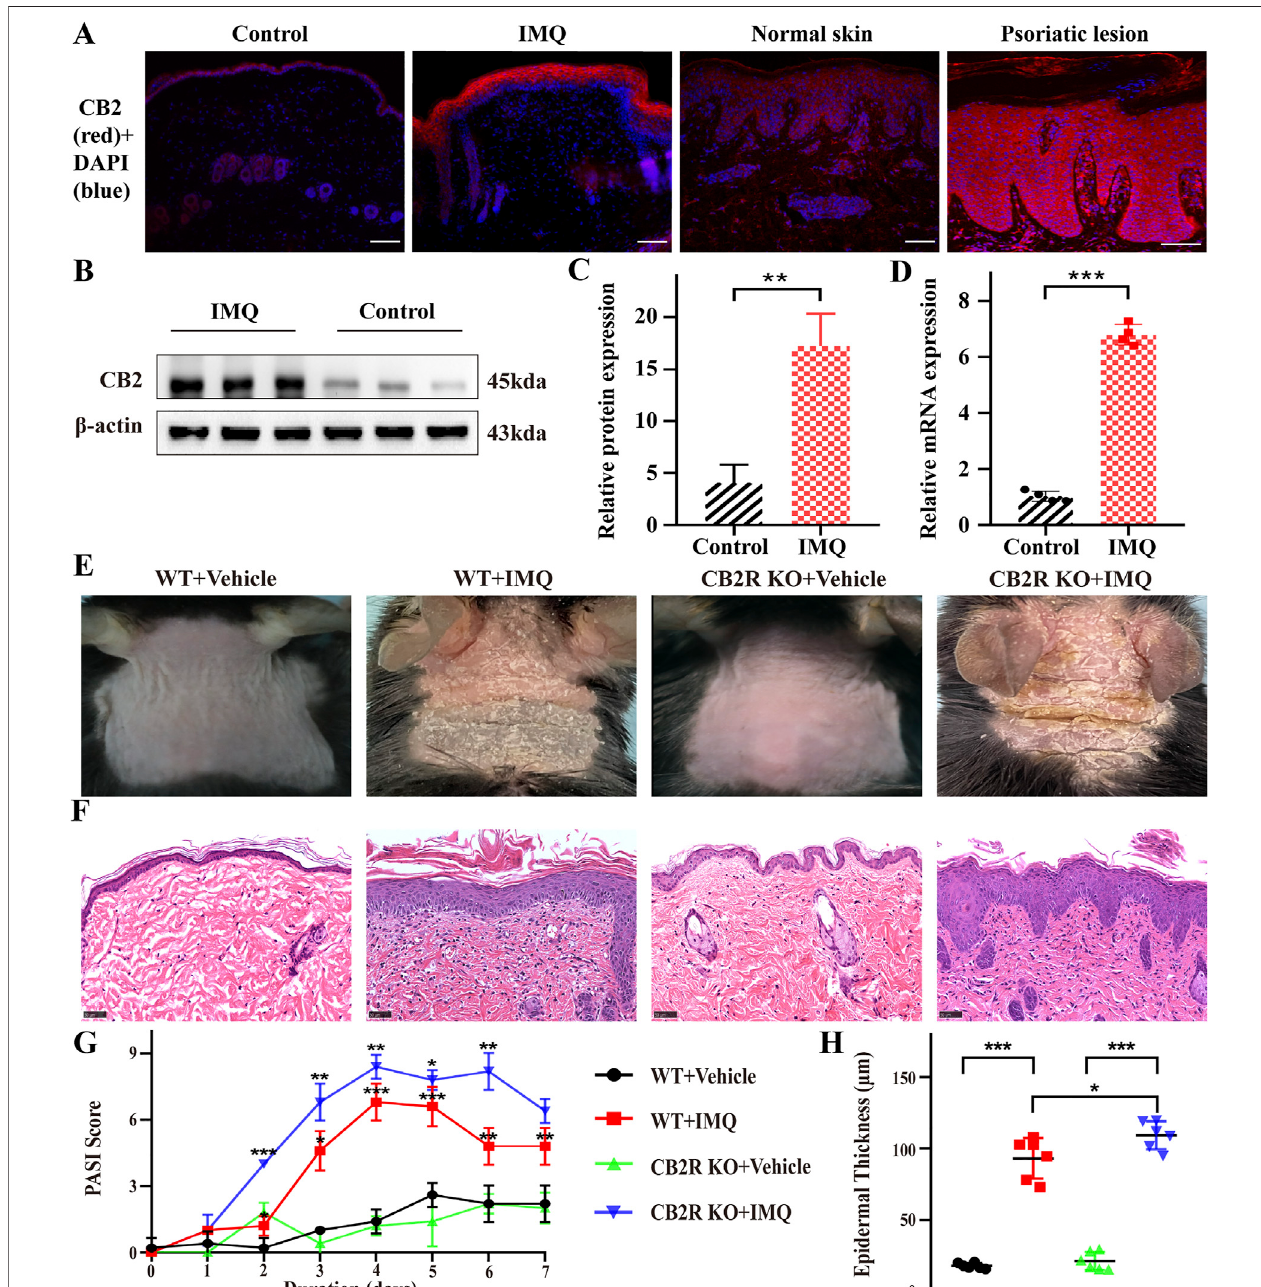
FIGURE 1 | CB2R was upregulated throughout the epidermis, and CB2R de fi ciency exacerbated the morphological and histological features of psoriasiform dermatitisinducedbyIMQtreatment. (A) Immuno fl uorescencewasusedtodetect theproteinlevelofCB2R inpsoriasiform dermatitis,humannormalskin andpsoriasis lesions (scale bar: 100 μ m). blue, DAPI; red, CB2R. (B, C) Protein levels of CB2R were quanti fi ed by western blotting. β -actin was used as a loading control. Relative protein expression was normalized to that of the internal control. (D) mRNA levels of CB2R in skin tissues from the normal and psoriasis groups were analyzed by real-time quantitative PCR. (E) Representative phenotype manifestation of WT and CB2R KO mouse back skin induced by IMQ application at day 7. (F) H&E staining of cross-sectionalslicesofthedorsalskinofC57BL/6miceontheseventhday.Scalebarrepresents50 μ m. (G) Clinicalscoresfordiseaseseveritywerecalculateddailyof epidermal erythema, scales, and thickening of the dorsal skin. The PASI score was calculated by adding the scores of three independent criteria (ranging from 0 to 12). (H) The epidermal thickness ofthe dorsal skin on the seventh day wasmeasured by four randomly selected fi elds per section ofeach mouse. Results are representative of three independent experiments. Error bars represent mean ± SD. ( n = 5 for each group). * p < 0.05, ** p < 0.01, and *** p < 0.001 when compared.